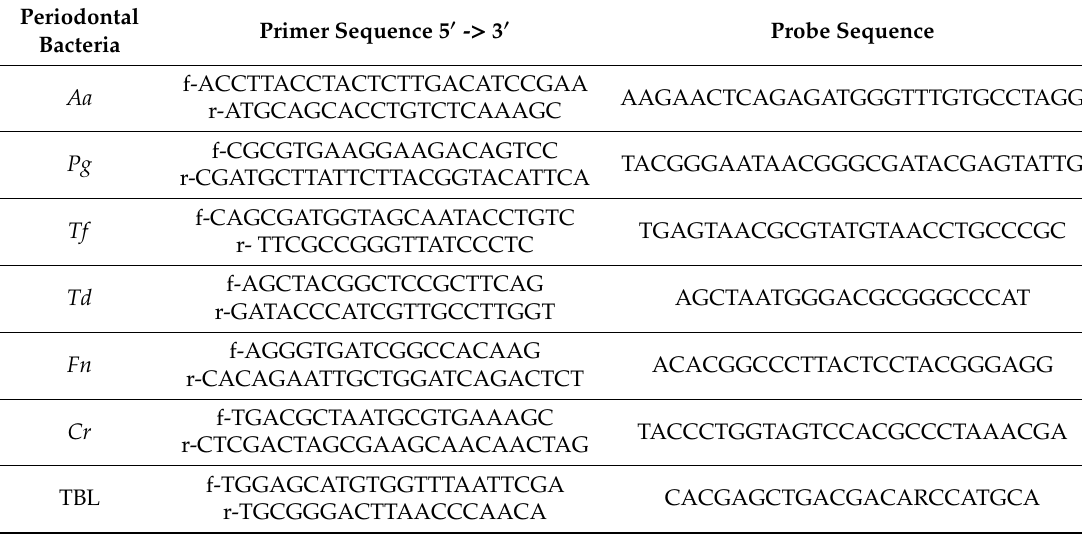
Table 1. Probe and primer sequences use for periodontal bacteria